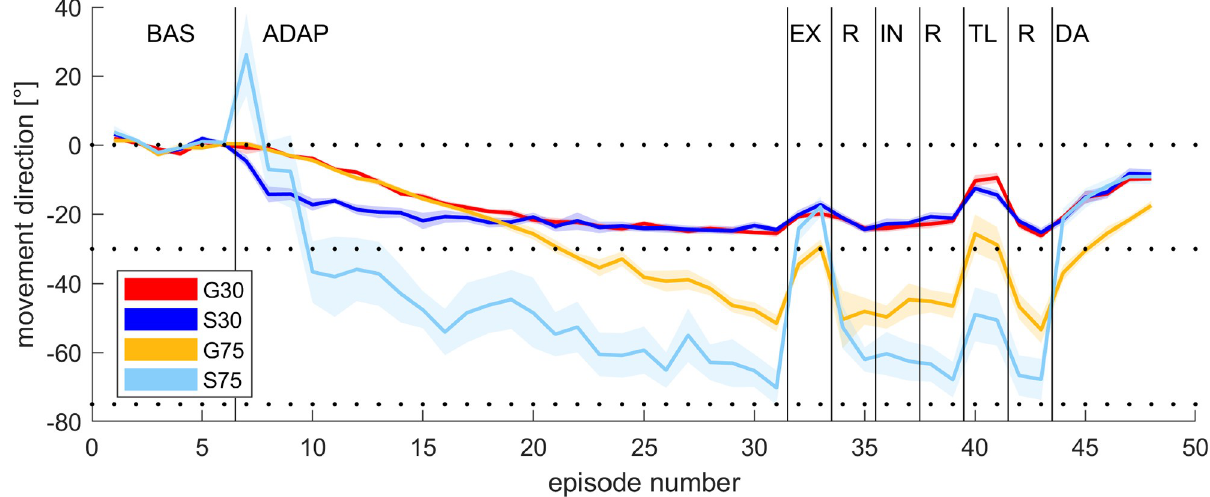
Fig 2. Mean angular movement errors of all blocks and groups. Shown are baseline (BAS), adaptation (ADAP), exclusion (EX), refresh (R), inclusion (IN), intermanual transfer (TL) and de-adaptation (DA). Lines indicate across-subject means, and the shaded area display standard errors.